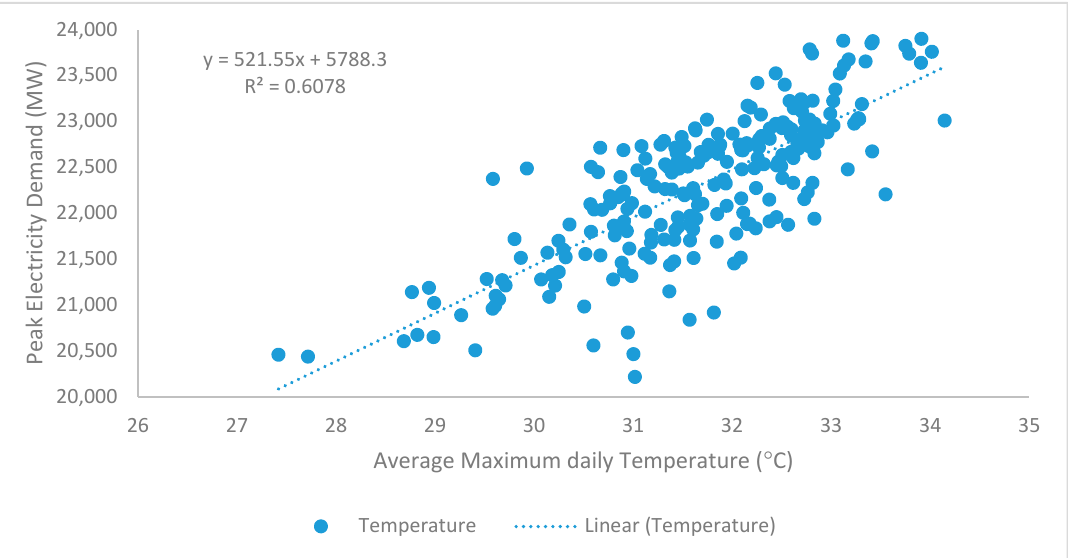
Figure 3. Peak electricity demand in the Java-Bali grid as a function of maximum daily temperature: weekdays 2014 (240 data points). Source: own fieldwork.